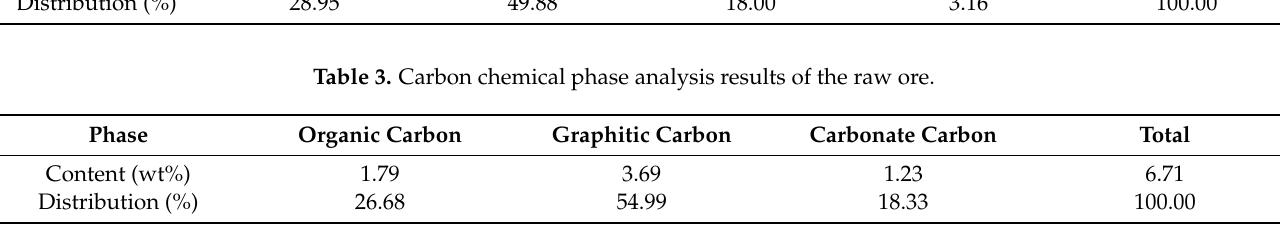
Table 3. Carbon chemical phase analysis results of the raw ore.